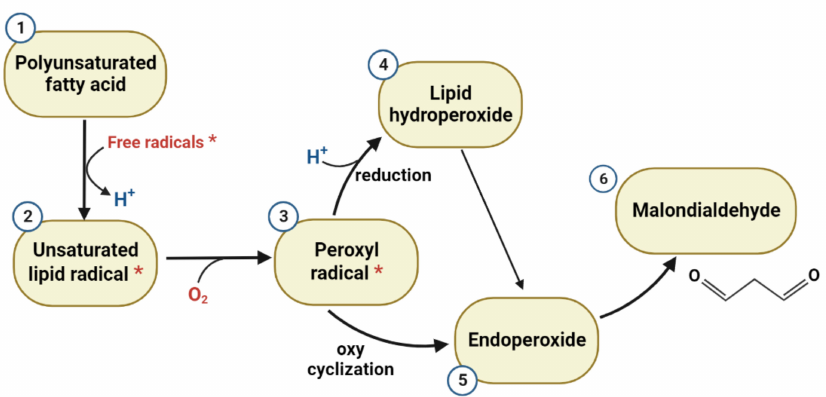
Figure 2. MDA generation cycle: (1) the high reactivity of polyunsaturated fatty acids to oxidizing agents is promoted by the methylene groups positioned between the cis double bonds along the chain. The removal of the hydrogen atoms leads to unsaturated lipid carbon-centered radicals (2) that are vulnerable to oxidizing and conversion into highly unstable peroxyl radicals (3). Depending on the position of the peroxyl radical in the carbon chain, two pathways are possible: terminal position at one of the two ends of the double bond system will result in reduction to conjugated diene hydroperoxides (4), while internal position will result in multiple products by mono- and/or bi-cyclizations, coupling to O2 or reductions. The fragmentation of a bicyclic peroxide compound (5) structurally analogous to the prostaglandin endoperoxide generates the malondialdehyde (6), *: free